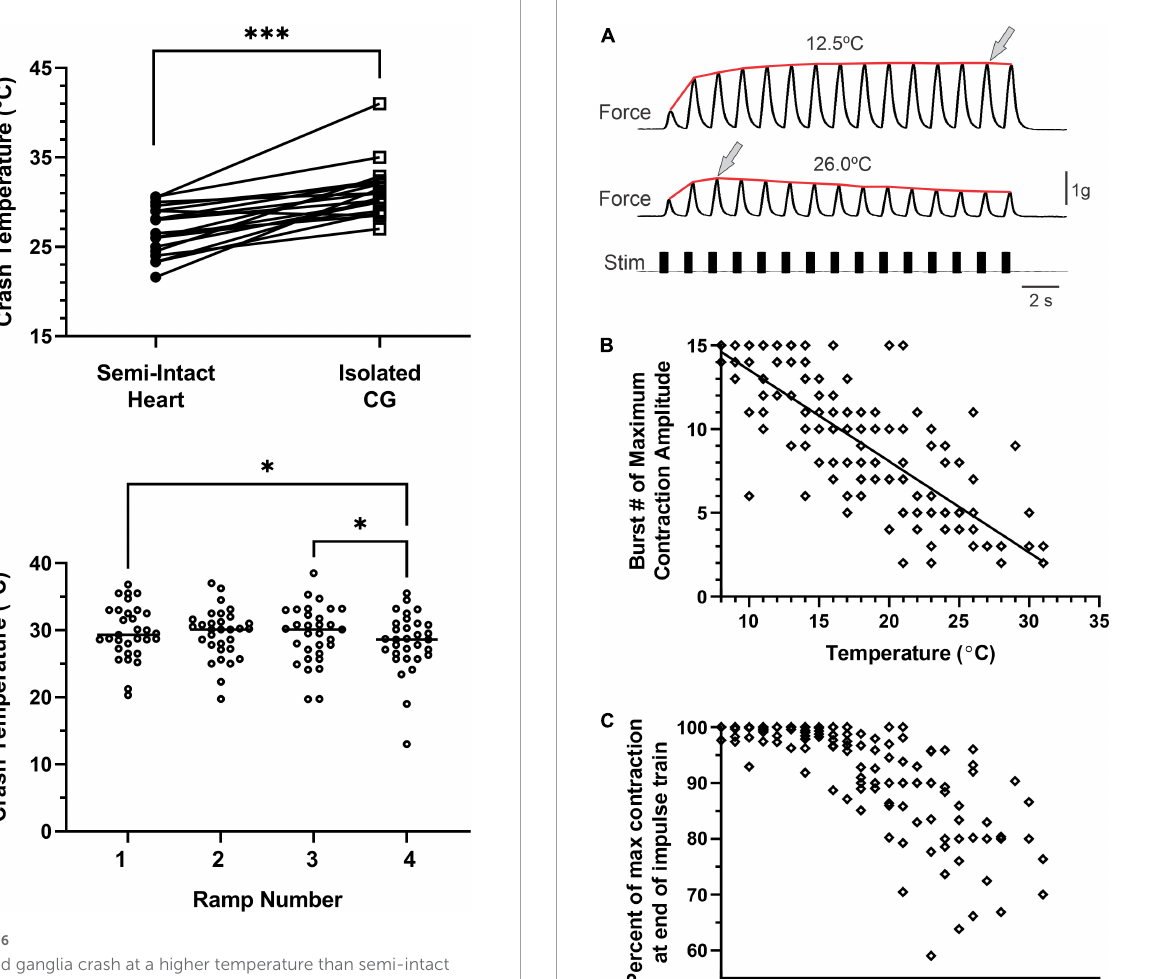
the muscle facilitation/defacilitation relationship. First, to examine the temporal relationship of the facilitation vs. defacilitation of muscle contraction, we plotted the number of the stimulus (indexed to 1) that generated the maximum contraction amplitude for each temperature. Each stimulus train generated fifteen stimuli ( Figure 7A , stim. trace), so values on this plot are bounded between 1 and 15. As temperature was increased, the maximum contraction amplitude